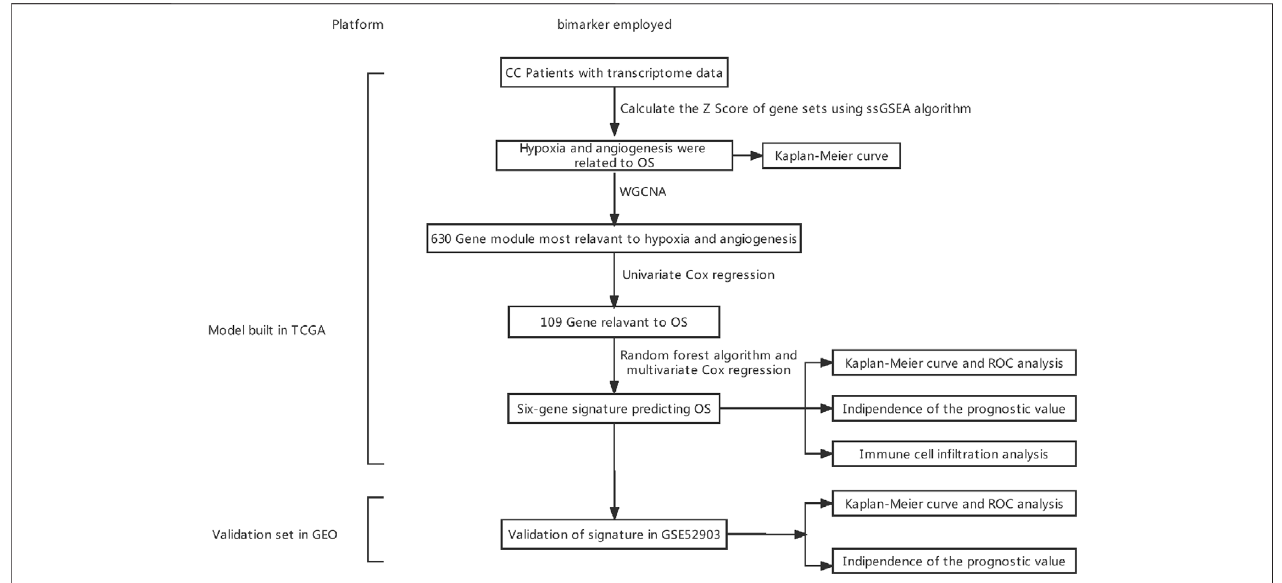
FIGURE 1 | Experimental fl owchart. CC, cervical cancer; WGCNA, weighted gene co-expression network analysis; ssGSEA, single-sample gene set enrichment analysis; OS, overall survival; ROC, receiver operating characteristic.